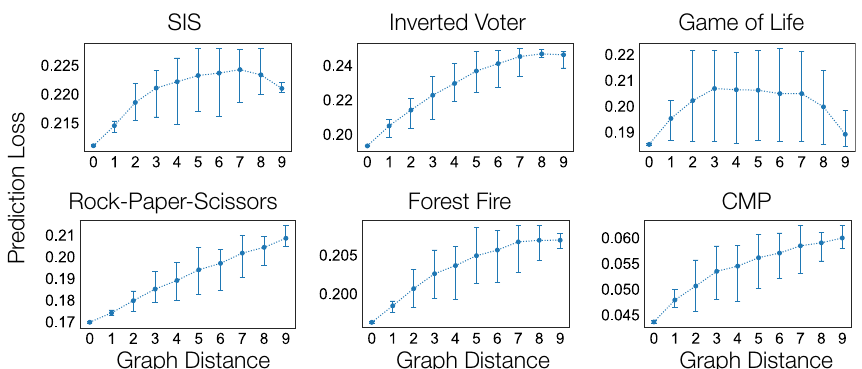
Fig. 5 Exp. 1: [Lower is better.] Computing the loss landscape based on all possible 5-node graphs. x -axis: Graph distance to ground truth adjacency matrix. y -axis: Mean prediction loss of corresponding graph candidates. Error bars denote